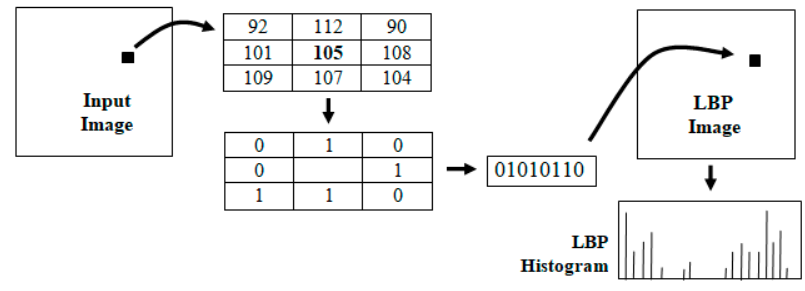
Figure 5. The intermediate steps in the computation of the LBP histogram of an image.